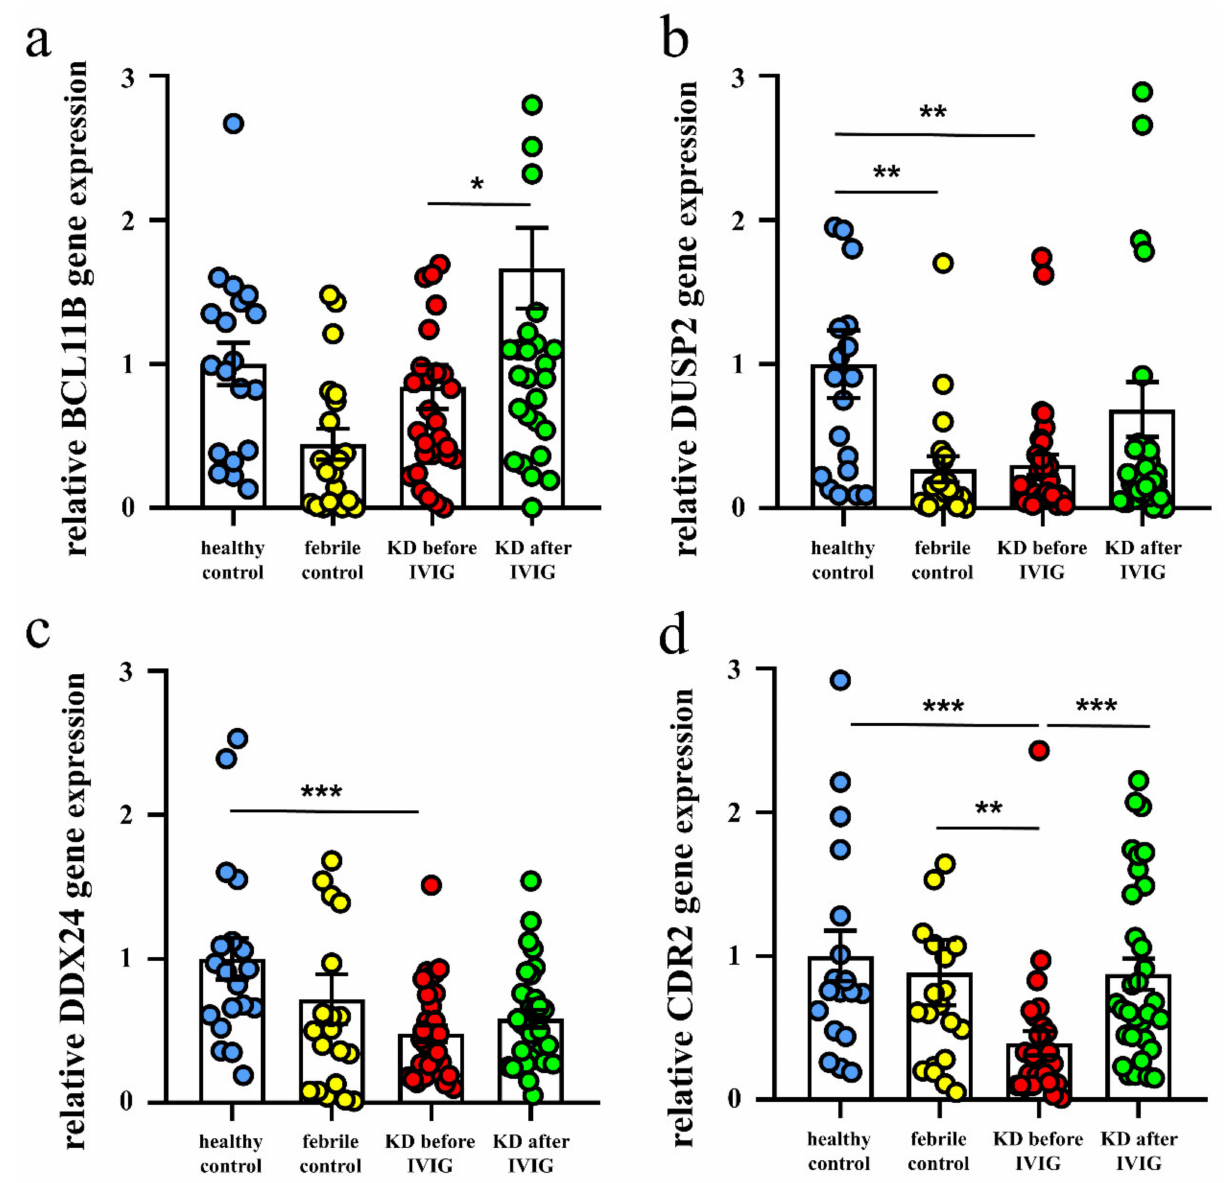
Figure 3. Comparison of BCL11B ( a ), DUSP2 ( b ), DDX24 ( c ), and CDR2 ( d ) expression determined by quantitative real-time reverse transcription polymerase chain reaction between acute-stage Kawasaki disease patients and control subjects. * Indicates significance ( p < 0.05), ** indicates significance ( p < 0.01). *** indicates significance ( p < 0.001) Data are expressed as mean ± standard error for the three